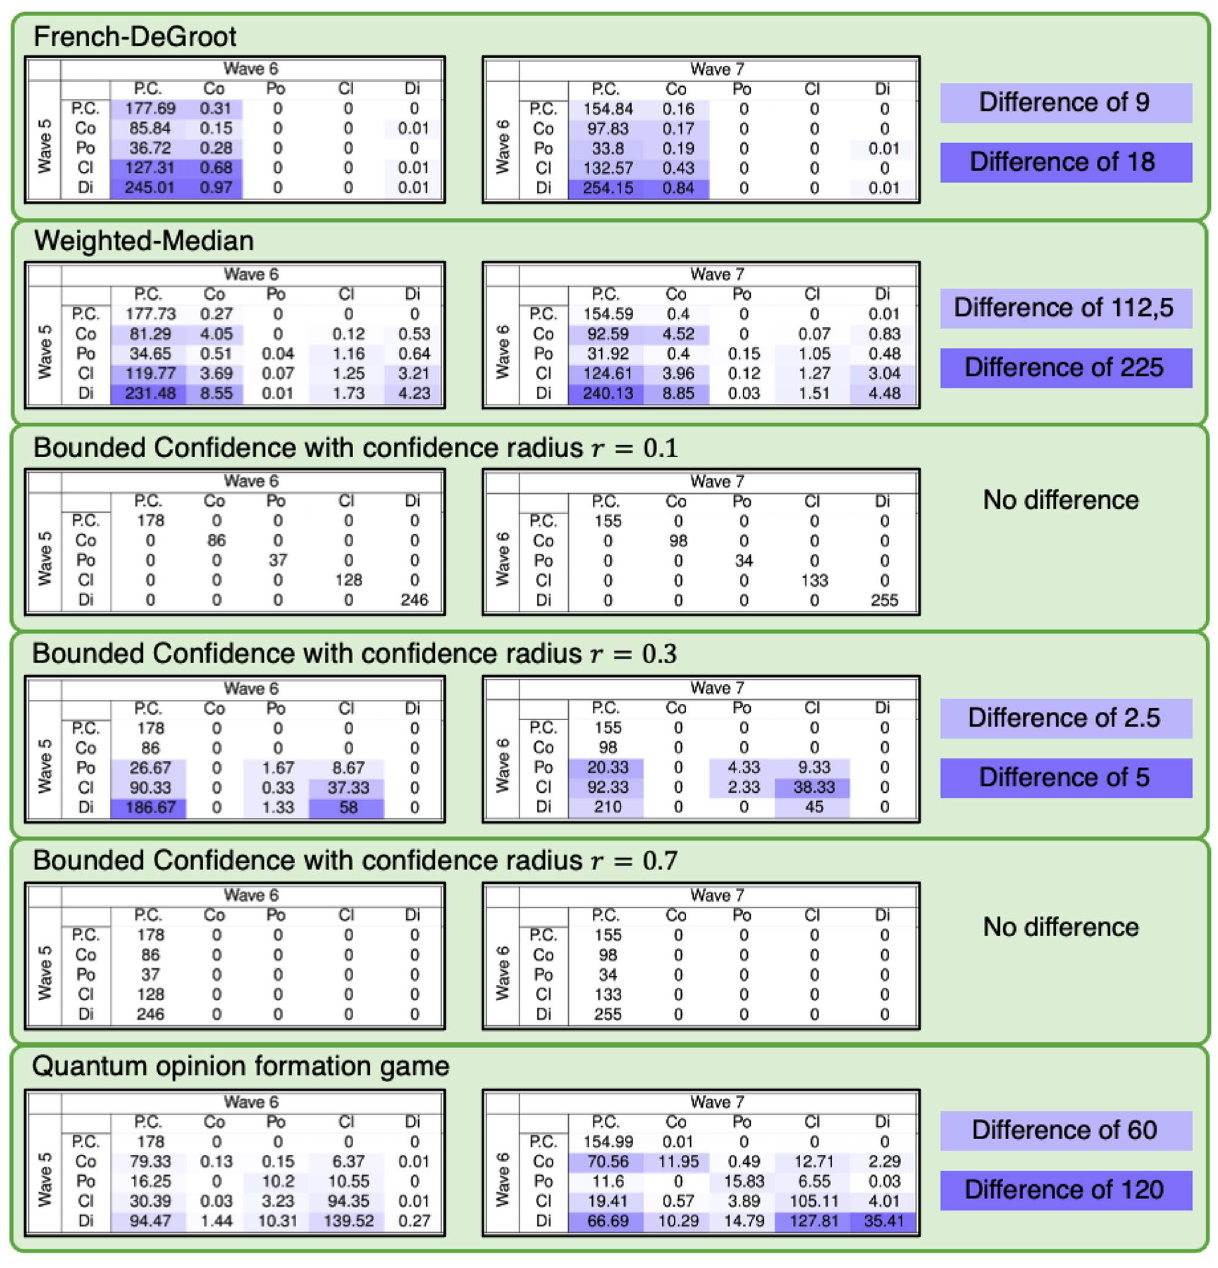
Figure 4. Average predicted transition tables from wave 5 to 6 (left), and 6 to 7 (right) for the six considered models. Each table entry contains the average of the corresponding values in the 75 computed transition tables, obtained for different population sizes, graph topologies, and initial opinion assignments. The variability of these values, in terms of the difference between the maximum and minimum value across all 75 tables, is denoted by the shade of blue. A cell with light blue color represents half the maximum difference for that model, and a cell with dark blue color represents the maximum difference for the model. The value of the difference represented by these shades of blue is reported to the right. A white cell means that all values are identical for all 75